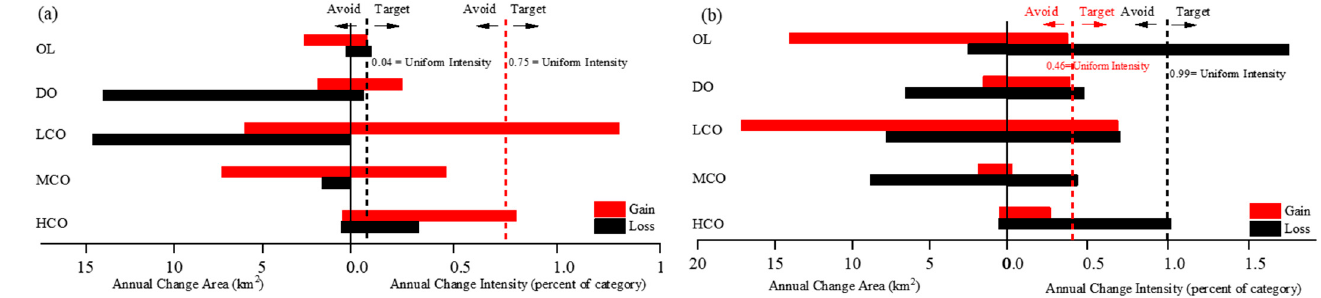
Figure 4. Transition-level intensity analysis of farmland for ( a ) 1984–2007; ( b ) 2008–2018.